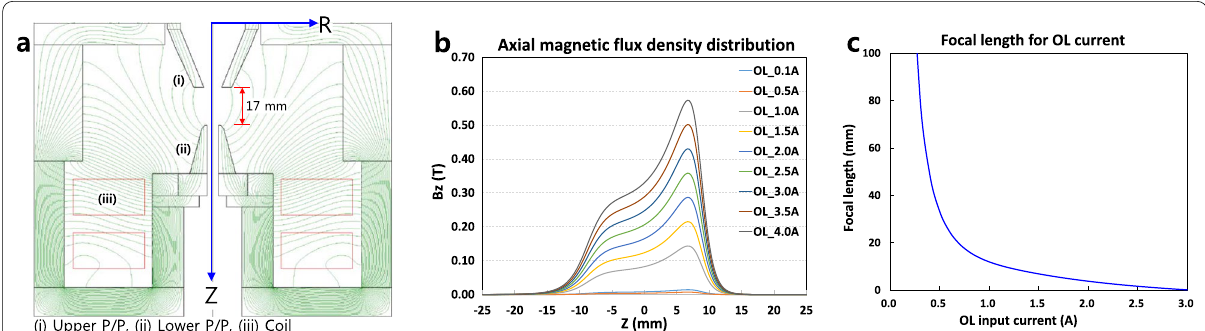
Fig. 1 The OL property of the developed low‑voltage TEM. a P/P structure and its equi‑flux density. b Axial magnetic flux density distribution for various input OL currents. c Focal length according to input OL